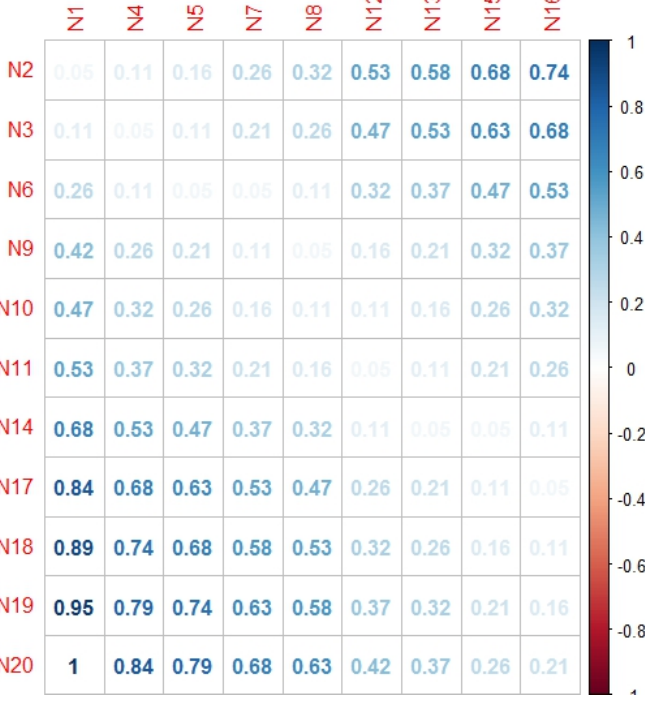
Figure 8. Statistical diagram of distance for moving-out and moving-in stations.